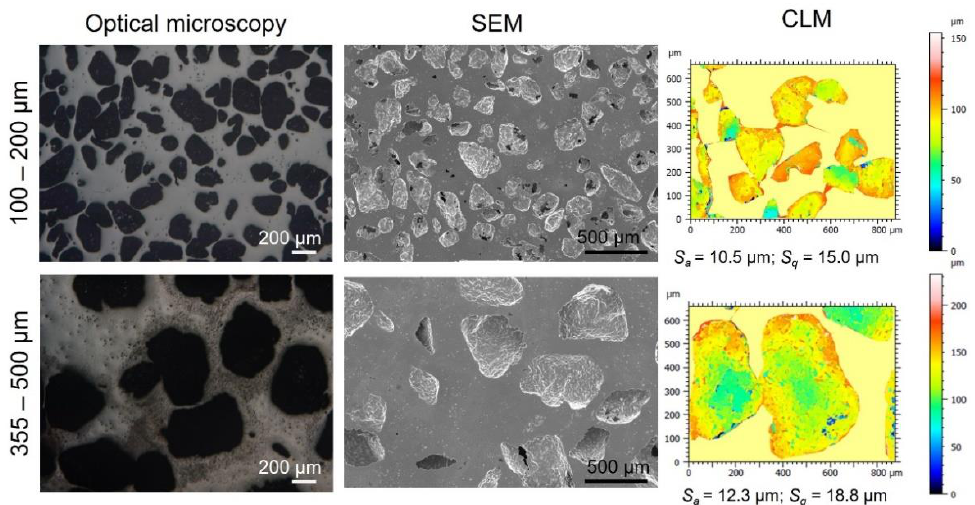
Figure 1. Images of the two pores ’ ranges of size distribution (100 – 200 and 355 – 500 µm) acquired with optical, SEM, and CLM, respectively. Surface roughness measured by CLM is also indicated.